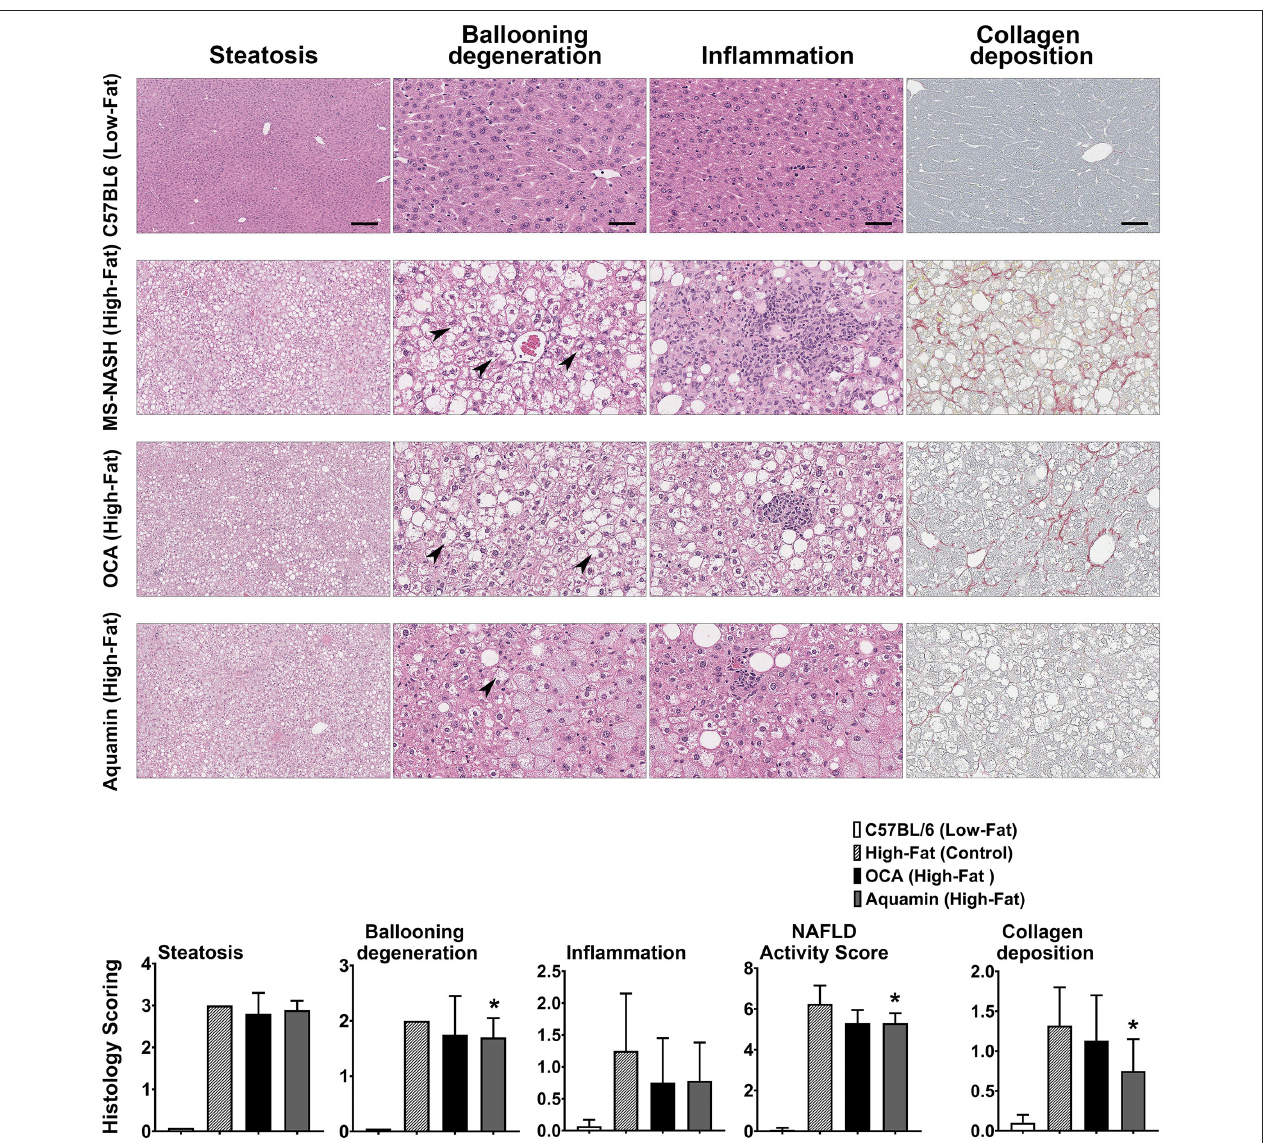
FIGURE 2 | Histological features. H&E-stained liver sections from all four groups were evaluated for steatosis, ballooning hepatocyte degeneration and inflammation by two trained individuals who did not know the treatment group from which the section was obtained. Arrows draw attention to the distended hepatocytes with clear cytoplasm and non-displaced nuclei representing ballooning degeneration. Inflammatory foci are visible in inflammation panels (of high-fat mice). The scoring of each parameter was conducted as described in the Materials and Methods Section and followed the Kleiner system (35). The NAFLD activity score (NAS) is a summation of the three individual parameters (steatosis, ballooning hepatocyte degeneration and inflammation), calculated in each mouse. Picrosirius red (PSR)-stained liver sections from all four groups were evaluated for collagen deposition. Values shown are means and standard deviations based on nine animals per group. Statistical significance was assessed by ANOVA followed by a two-tailed t -test. Asterisks (*) indicate statistical difference from high-fat control at p < 0.05. For steatosis panels, scale bar = 200 µ m, for ballooning degeneration, inflammation and collagen deposition (PSR) panels, scale bar = 50 µ